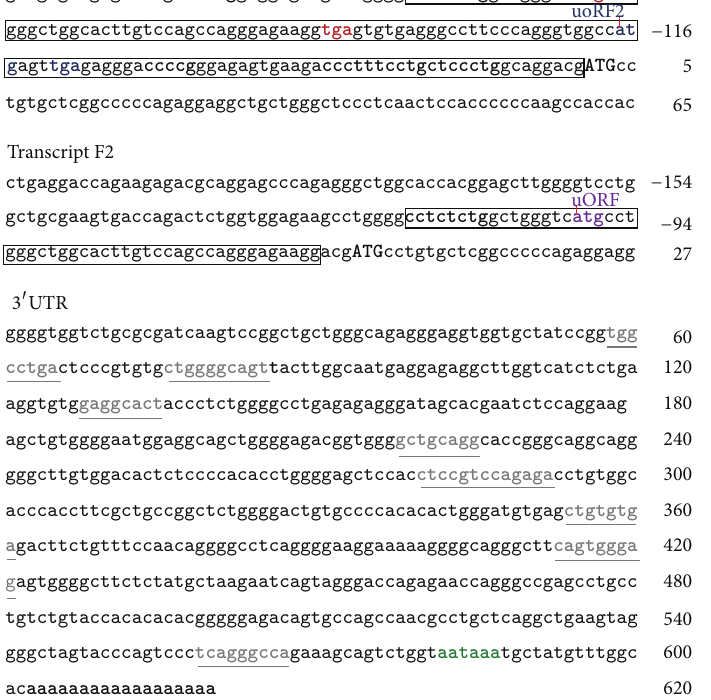
Figure 1: 5 󸀠 UTR and 3 󸀠 UTR nucleotide sequences of MC1R transcripts. The two different 5 󸀠 UTR nucleotide sequences (transcripts F1 and F2) and the common 3 󸀠 UTR of MC1R transcripts are presented separately under the appropriate headings. The predicted TOP regulatory motifs and IRES in 5 󸀠 UTR are indicated in black bold letters and box, respectively. The uORF start codons (atg) in the 5 󸀠 UTR sequences